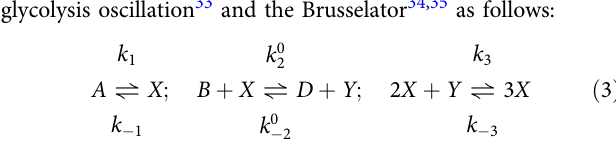
B (cid:5) , 2 ½ γ ≡ k − k − 2 3 / J fi eld) of the x , y ) (vector